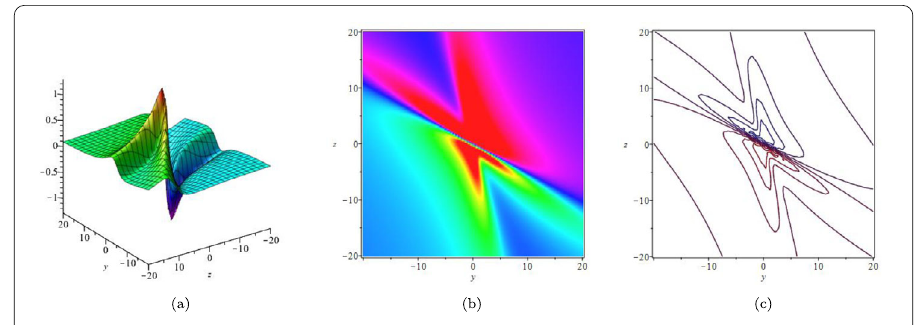
Figure 11 The interaction between line rogue wave and lump for Eq. (1.2) in the ( y , z ) plane with the parameters defined in Eq. (2.22): (a) three-dimensional plot at t = 0, (b) the density plot, (c) the corresponding contour